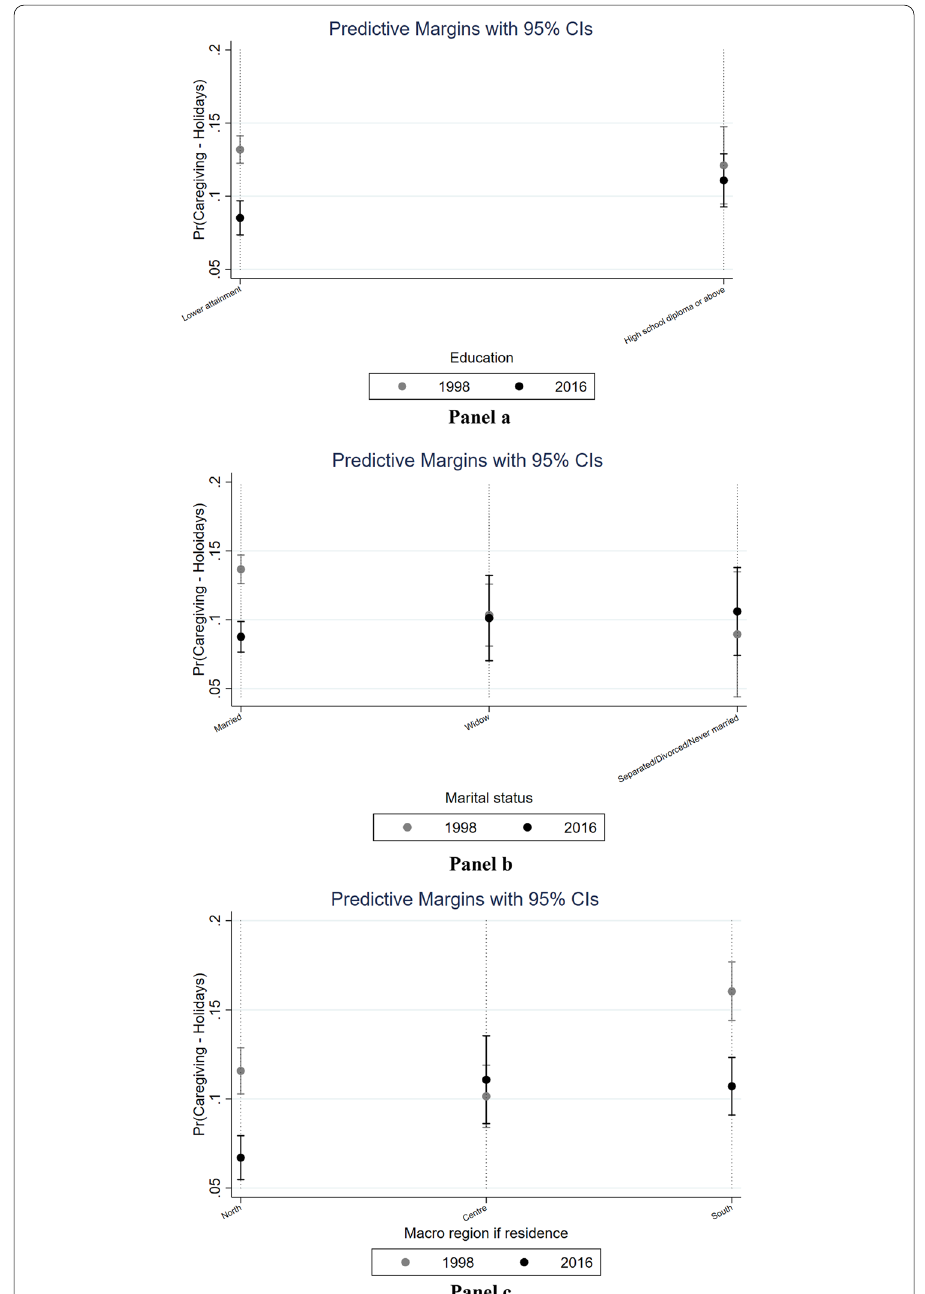
Fig. 3 Predicted probabilities grandchild care during holidays—changes over